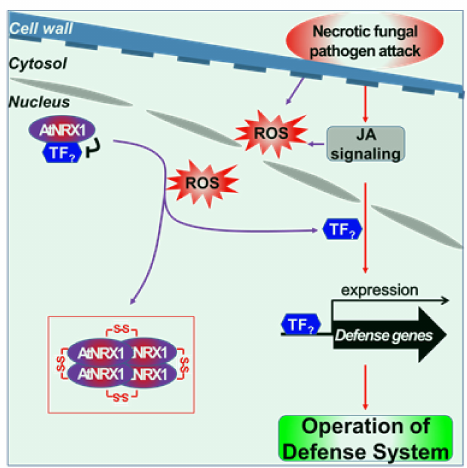
Figure 7. Model depicting the mode of action of AtNRX1 in the JA-dependent defense system under normal (no stress) and biotic stress conditions. In this model, AtNRX1 inhibits the JA-dependent expression of defense-related genes under normal conditions. However, the external attack by necrotrophic fungal pathogen simultaneously produces JA and ROS. The associated accumulation of intracellular ROS results in the oxidation of the active site Cys residues of AtNRX1, which behave as a redox sensor and induce the structural modification (oligomerization) of AtNRX1 monomers. The decreased a ffi nity of oligomeric AtNRX1 for the TF ? (an unknown factor in the nucleus, such as a TF mediating JA signaling) results in the de-repression of TF ? , thus activating JA signaling and altering the expression profile of a subset of JA-responsive